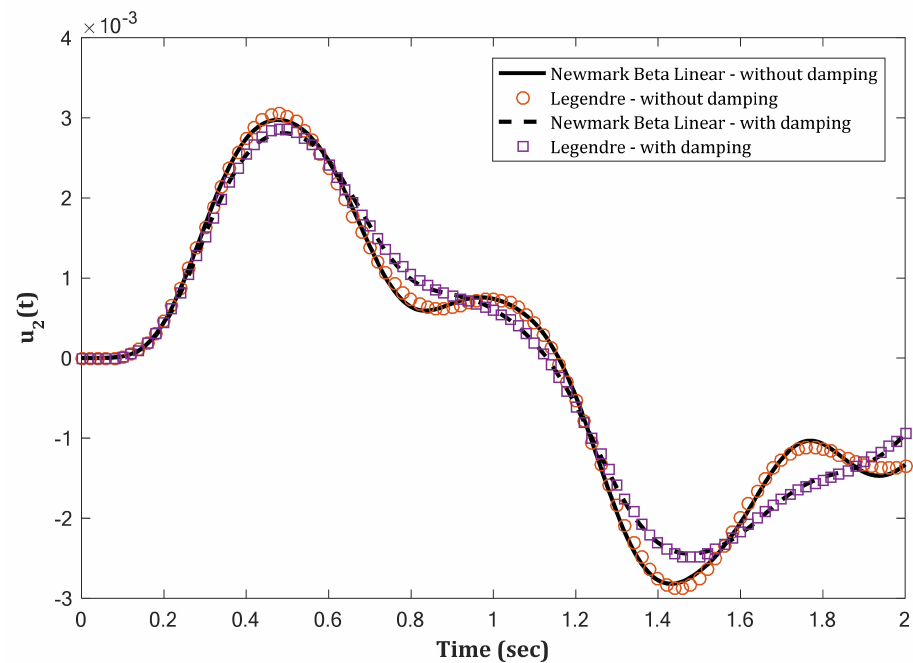
Figure 6. Forced vibration analysis of a 2DOF system. Comparison of u 2 ( t ) as a function of time, as obtained from the LGM method or the linear Newmark- β